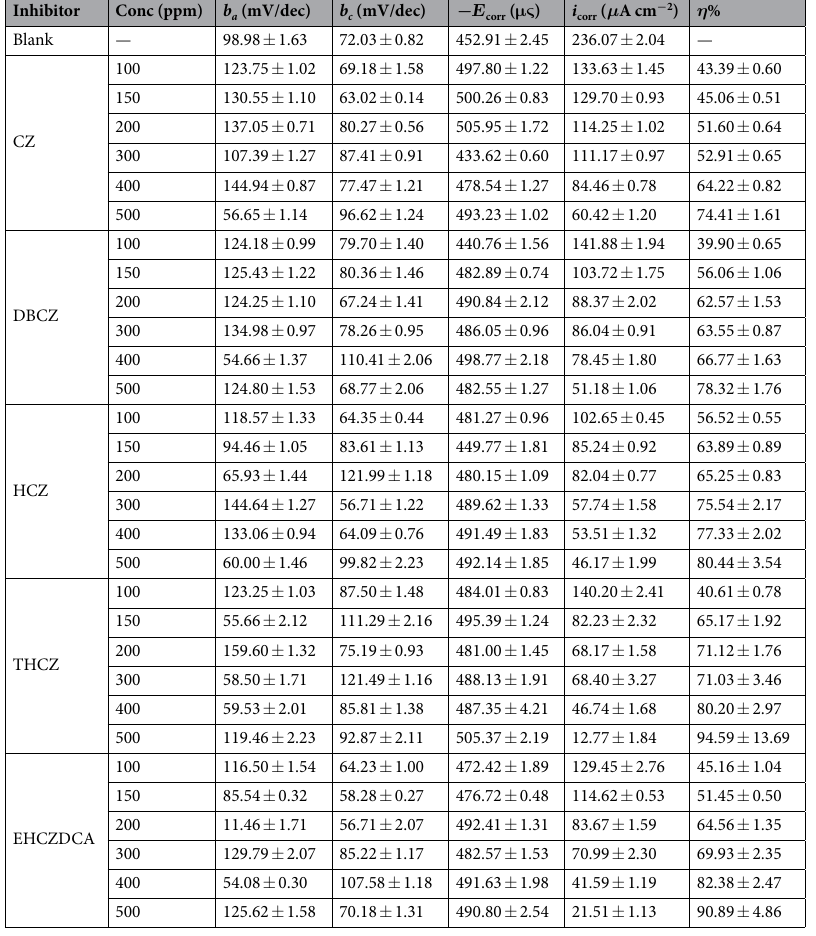
Table 2. Tafel polarization parameters for MS in 1 M HCl solution in absence and at different concentration of